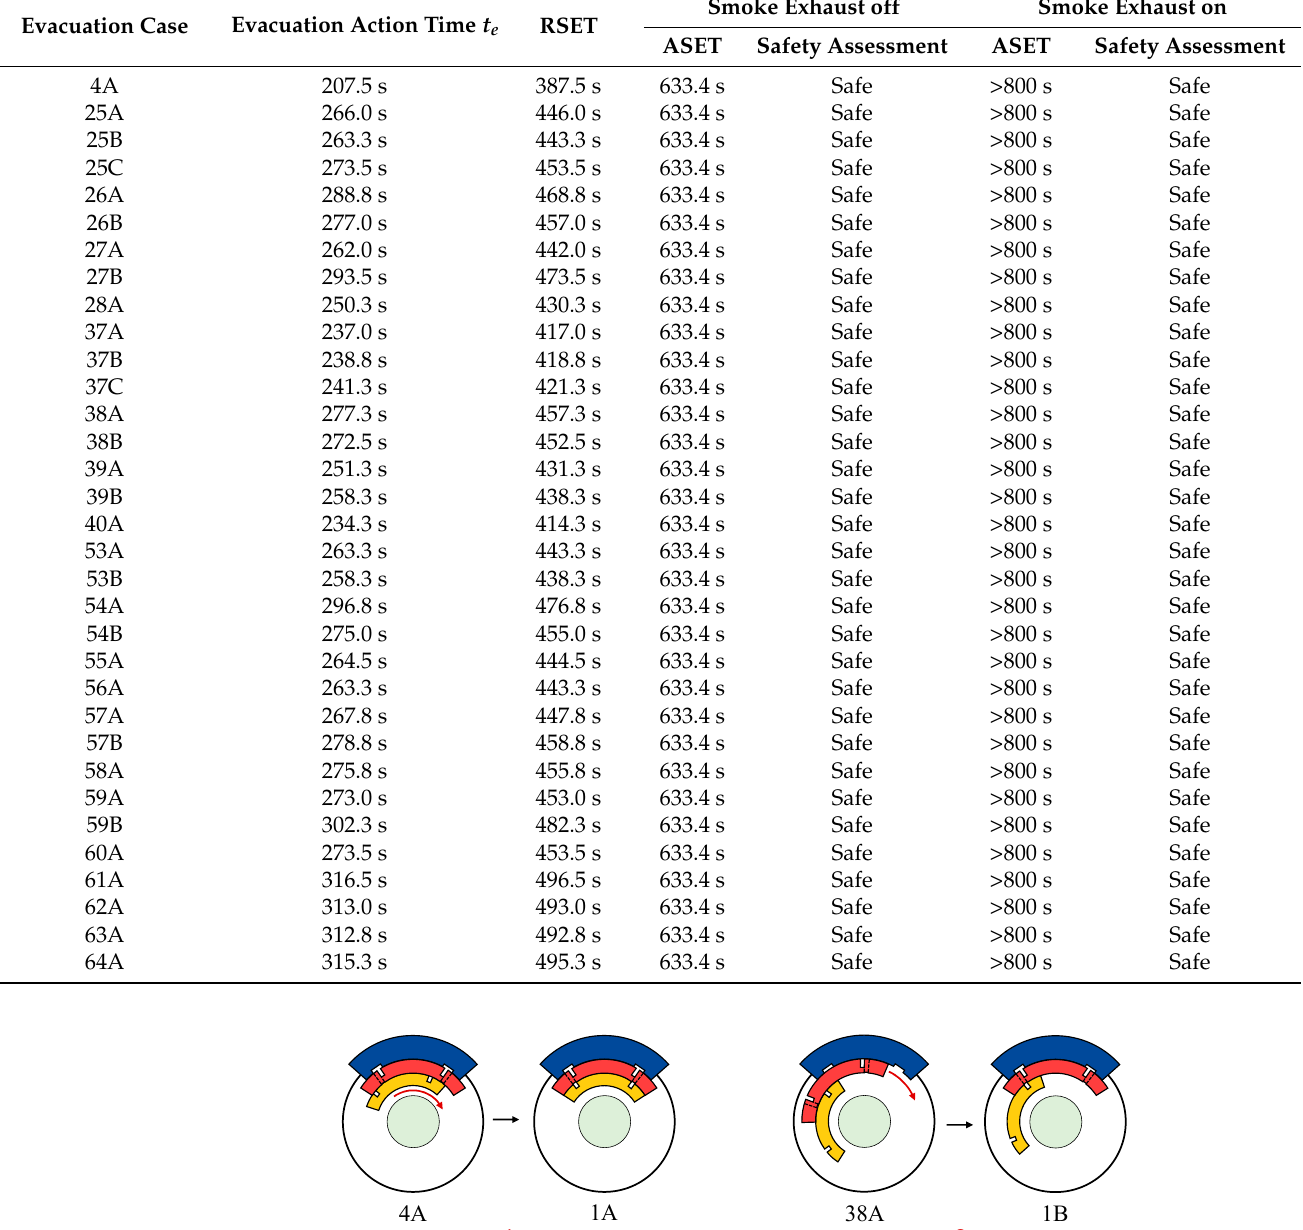
Table 9. Evacuation action time and evacuation safety time after setting emergency evacuation stairs.